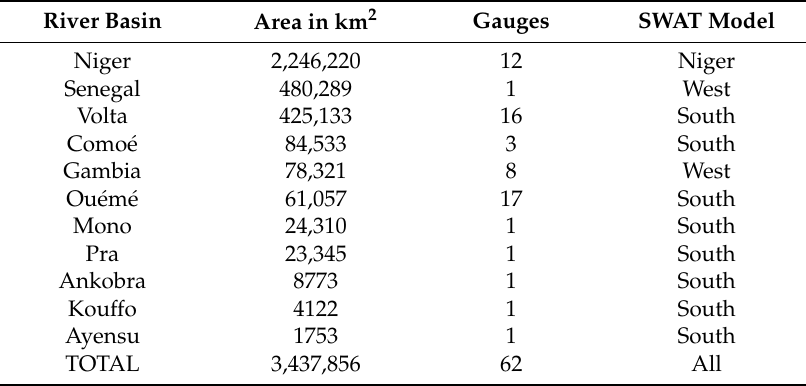
Table 1. Selected River Basins and Discharge Gauges in the Study